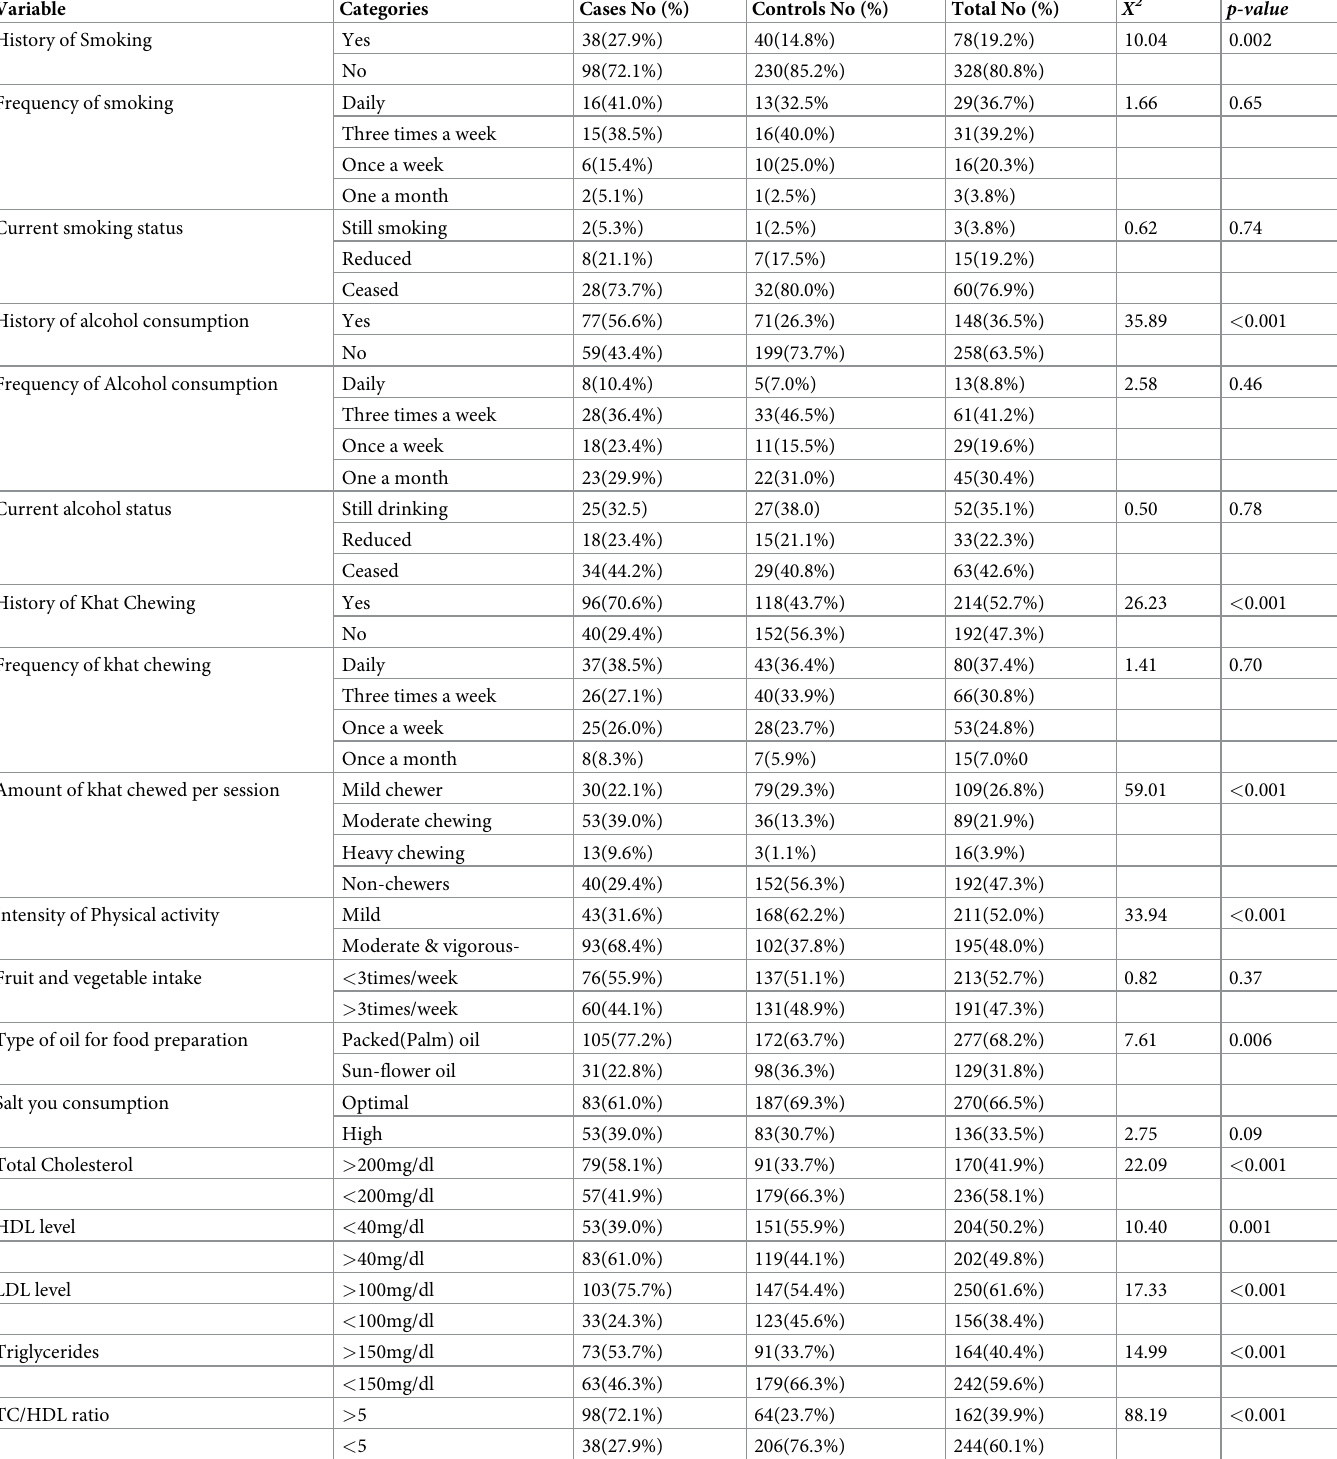
Table 2. Behavioral, nutritional and biochemical hypertensive risk factors among patients in southwest, Ethiopia,